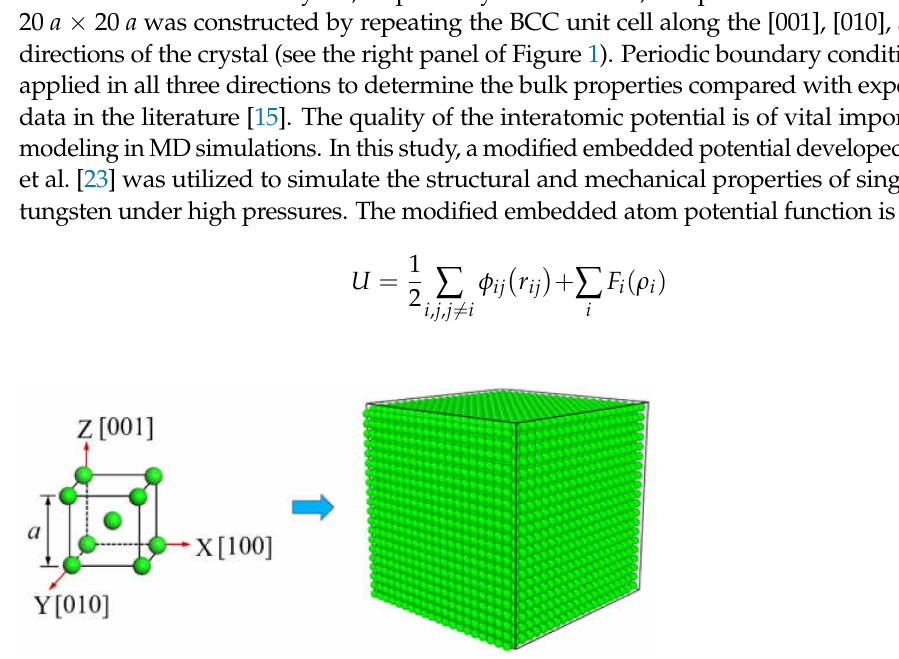
Figure 1. A BCC unit cell with a lattice parameter of a = 3.165 Å (left panel) and a schematic representation of a cubic single tungsten crystal with a size of 20 a × 20 a × 20 a based on the BCC unit cell (right